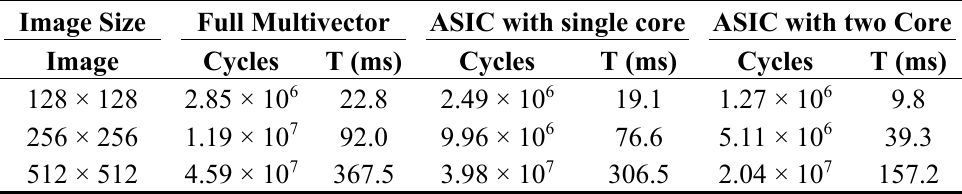
Table 7. Two geometric products for rotor